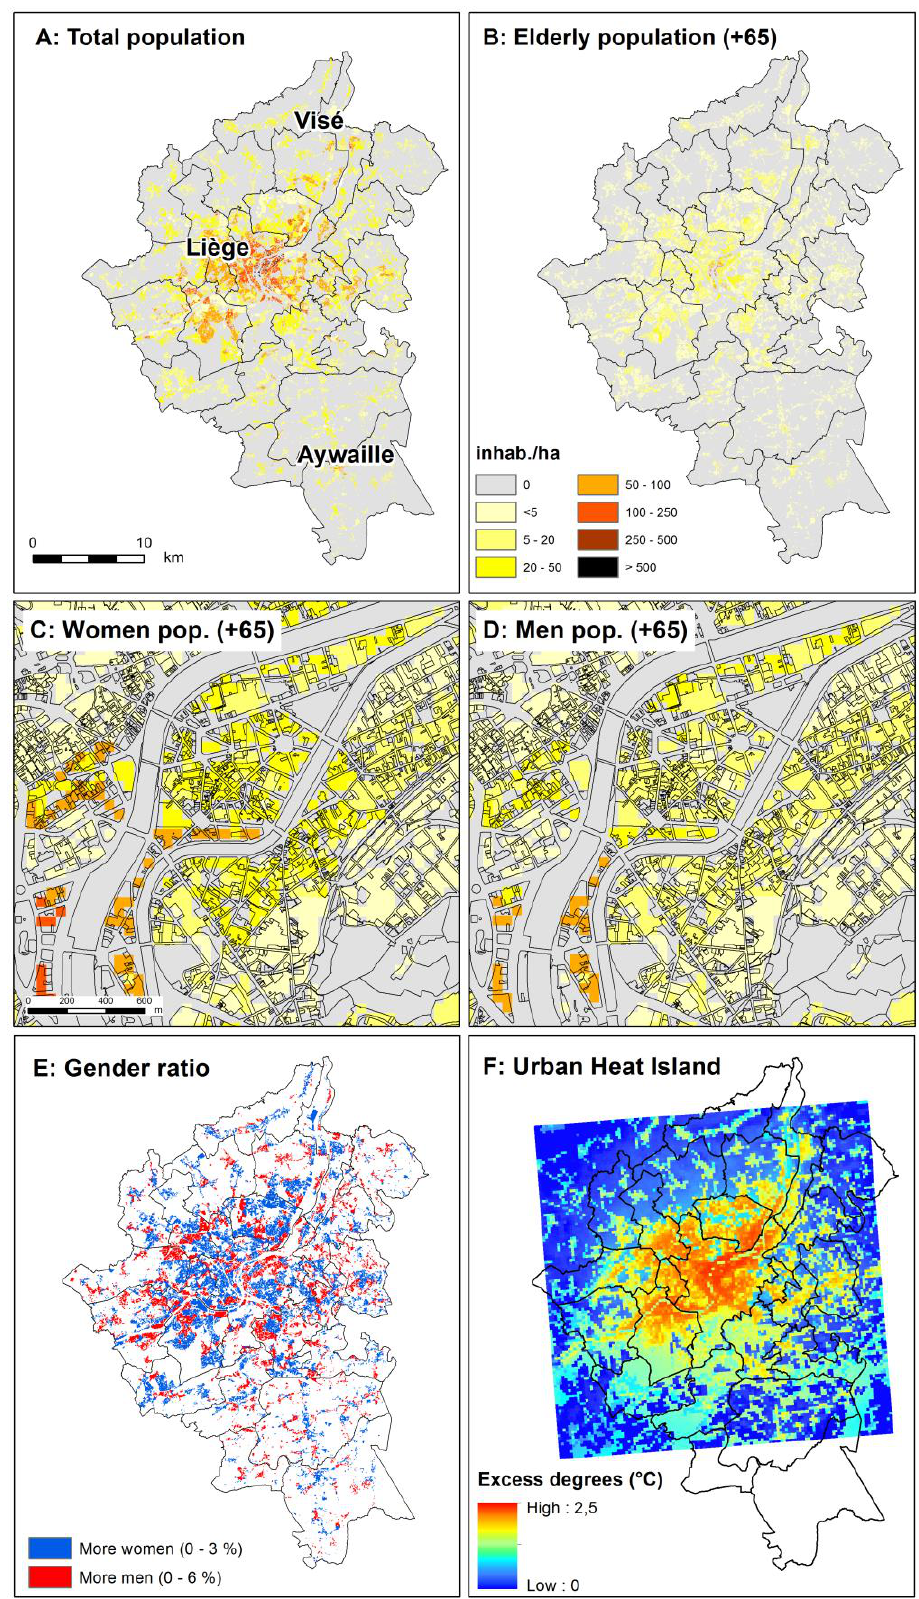
Figure 5. (a) Total population; (b) Elderly population (over 65 years); (c) Zoom on female population over 65 ; (d) Zoom on male population over 65 ; (e) Total population gender ratio; (f) Urban Heat Island (data from https://www.urban- climate.eu/services/eu_cities, 2011 summer, 250m spatial